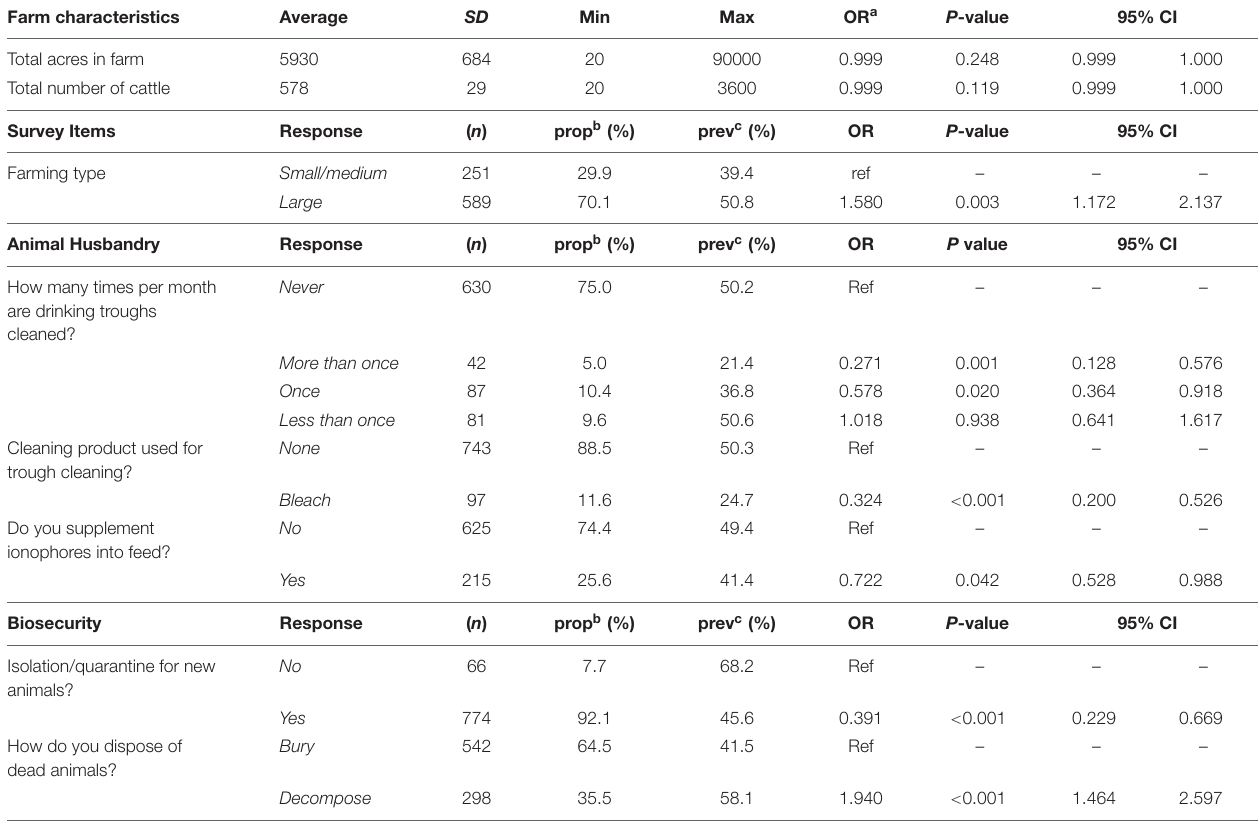
TABLE 3 | Association between farm characteristics and husbandry and the CRB prevalence. Farm